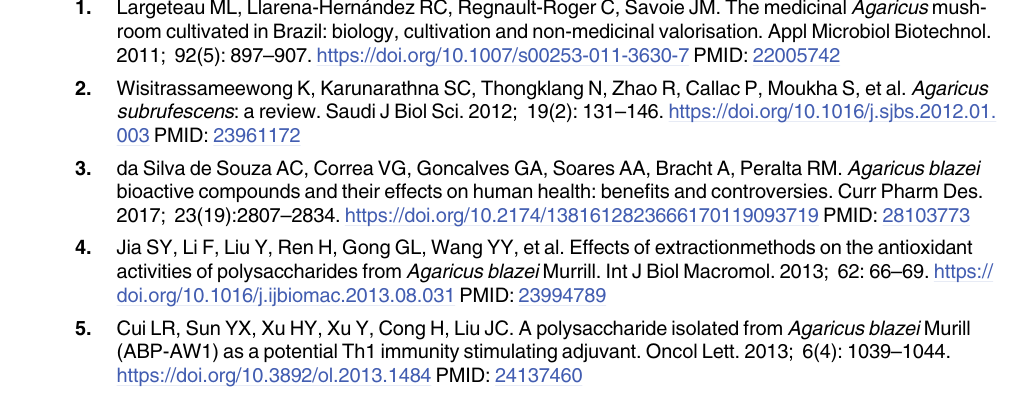
S6 Table. Significantly enriched KEGG pathway of DEGs from different